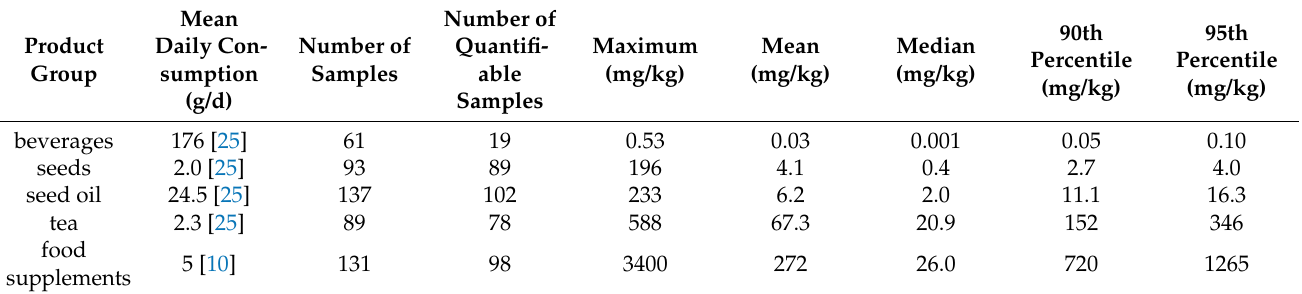
Table 2. Daily consumption, number of (quantifiable) samples, and maximum, mean, median, and 90th and 95th percentile of ∆ 9 -tetrahydrocannabinol in hemp tea, hemp seed oil, hemp seeds, hemp food supplements, and hemp